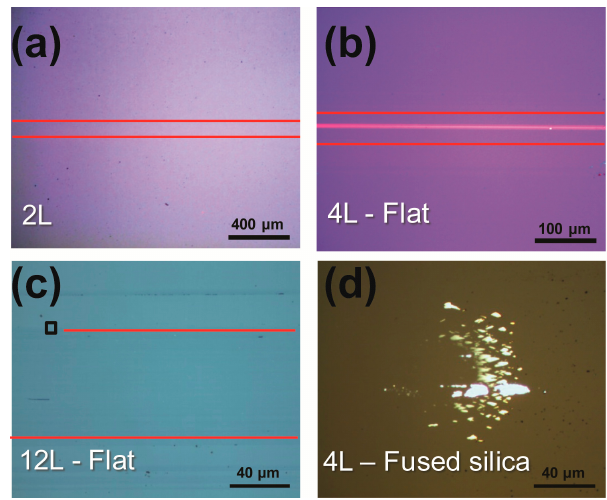
Figure 4. Optical images of the wear tracks of ( a ) 2L MoS 2 , ( b ) 4L MoS 2 , ( c ) 12L MoS 2 , and ( d ) the fused silica counterpart after undergoing 5 cycles of sliding under low pressure. The black box in ( c ) corresponds to the AFM scanned area in Figure 5.